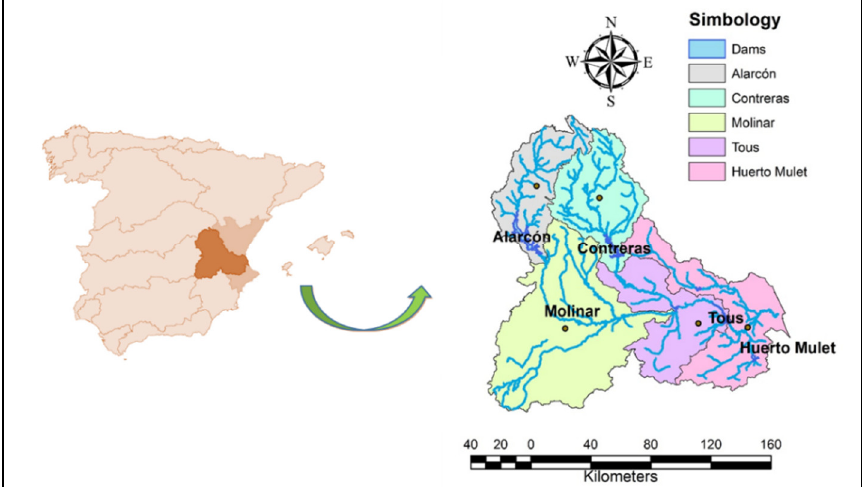
Figure 2. Location of Jucar River Basin.